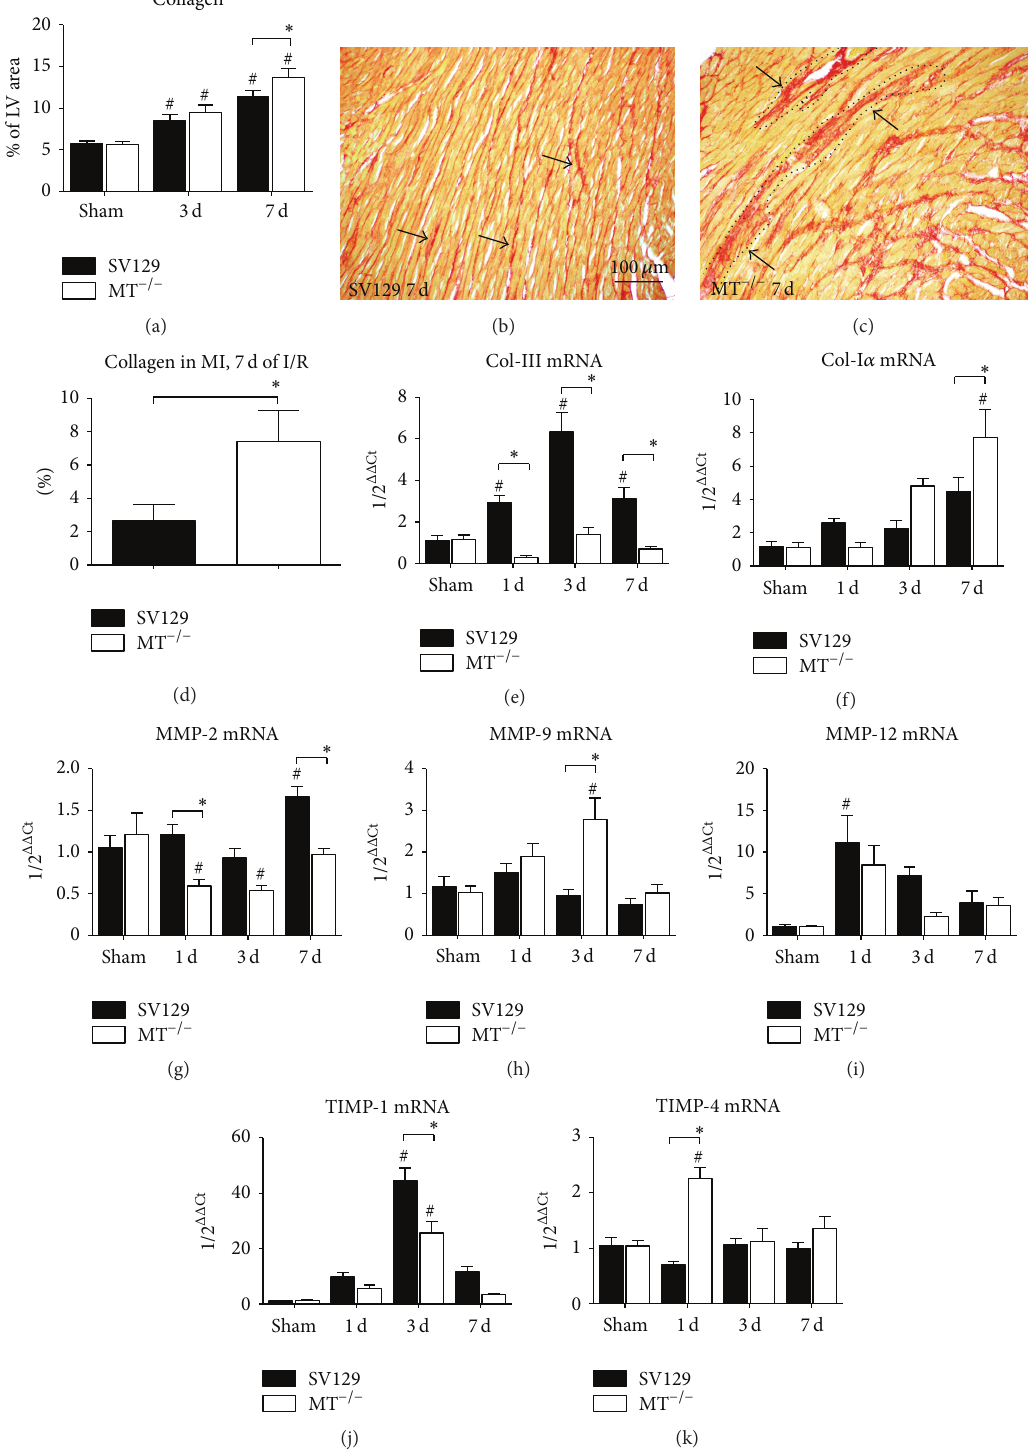
Figure 7: Scar formation and inadequate extracellular matrix turnover in MT −/− -mice. (a) Planimetric analysis of picrosirius red stainings shows increasing total collagen area after 3 and 7 days (d) in both genotypes. Representative picrosirius red stainings after 7days of I / R shows (b) interstitial fibrosis (arrows) in WT-heart, in contrast to (c) dense collagen deposition in microinfarctions (arrows, dotted line: microinfarcted area) in MT −/− -hearts. (d) Significantly higher collagen deposition in microinfarcted areas in MT −/− -hearts after 7days of I / R compared to WT. Evaluation of mRNA expression of (e) collagen (Col)-III, (f) Col-I 𝛼 , (g) metalloproteinase (MMP)-2, (h) MMP-9, and (i) MMP-12 as well as (j) tissue inhibitor of MMP (TIMP)-1 and (k) TIMP-4. 𝑛 = 8–10/group; scale bars in (b) and (c): 100 𝜇 m; RT-qPCR using Taqman, mRNA expression is related to shams and GAPDH using comparative ΔΔ Ct-method; ∗ indicates P ≤ 0.05 between the genotypes; # indicates P ≤ 0.05 versus respective